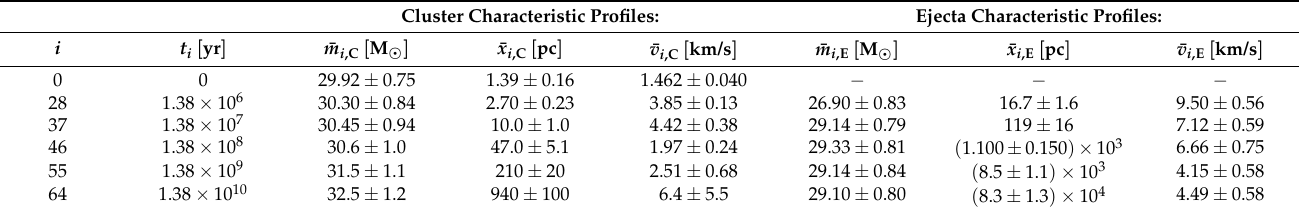
Table 15. Cluster and ejecta mean PBHs mean mass, position and velocity at selected time slices. These are extracted from the fitted Log-Normal and Maxwell–Boltzmann distribution parameters of Table 14 and by making use of Equations (6) and (11) of Section